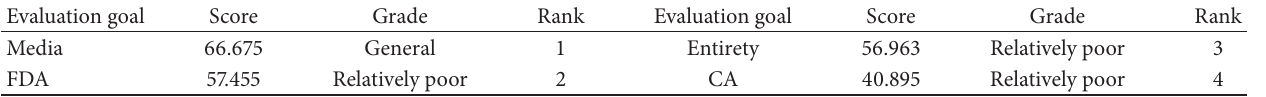
Table 8: Scores of various types of food safety supervision